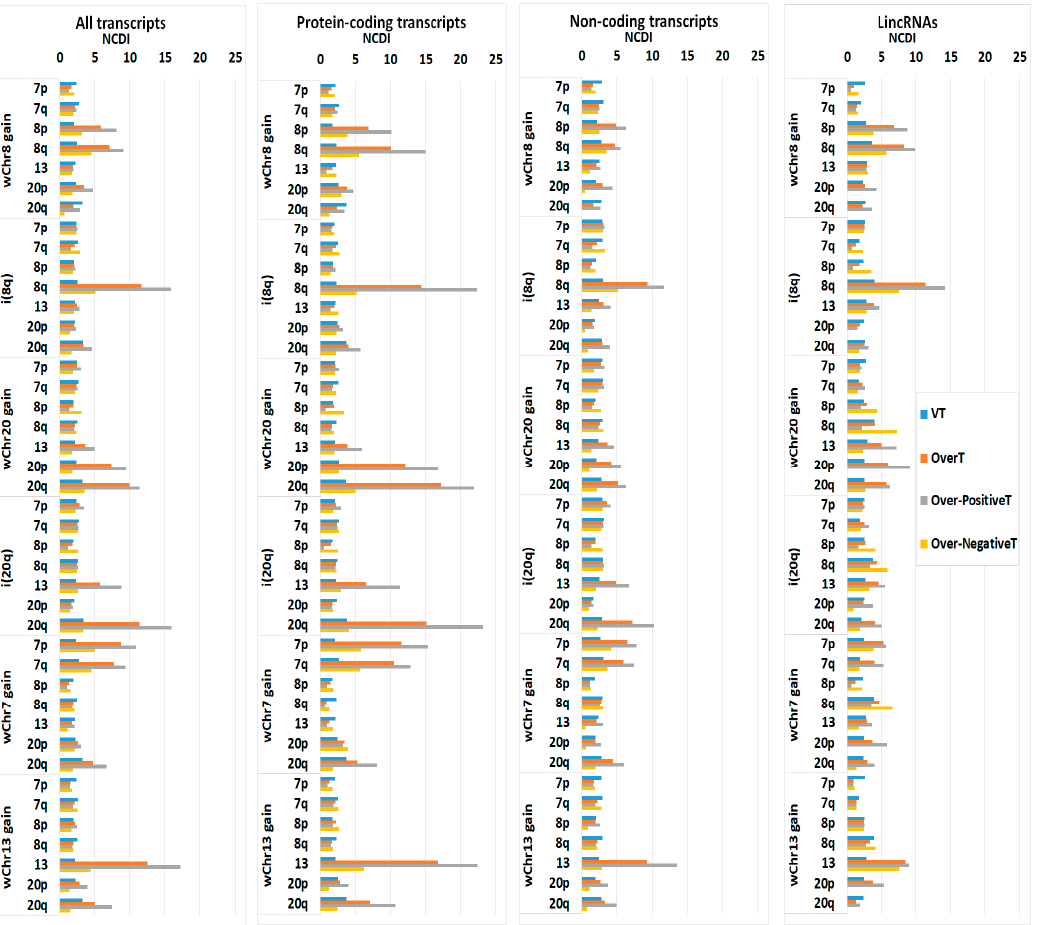
Figure 6. NCDI of different transcript classes (VT, OverT, Over-PositiveT, Over-NegativeT) in selected chromosomal arms or acrocentric chromosomes in different groups of CIN COAD samples. Calculation of NCDI values are reported for all transcript types or, separately, for “Protein-coding”, “Non-Coding” and “lincRNA”. Table 1. Fold-enrichment of OverT among different classes of transcripts evaluated by hypergeometric test.